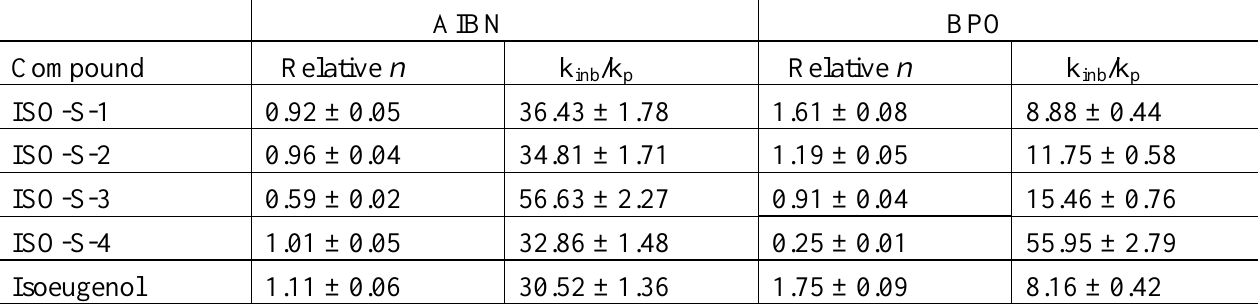
Table 1 . Radical-scavenging activity of the reaction products of isoeugenol ( 1 ) with ethanethiol, thiophenol, 2-mercaptothiazoline or 2-mercapto-1-methylimidazole (ISO-S-1 – ISO-S-4) in the polymerization of methyl methacrylate initiated by AIBN and